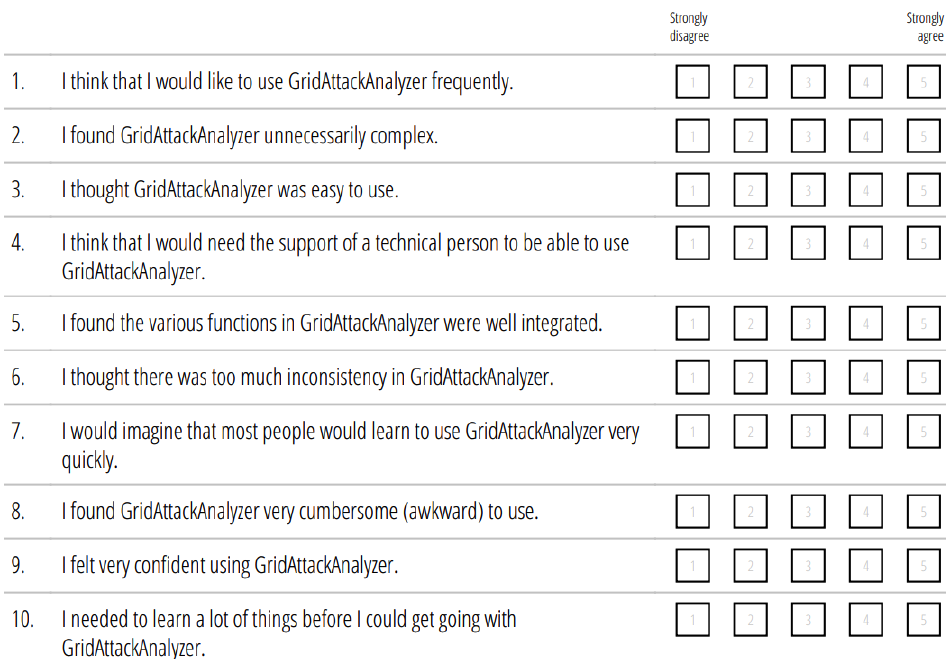
Figure 8. SUS questionnaire for GridAttackAnalyzer.